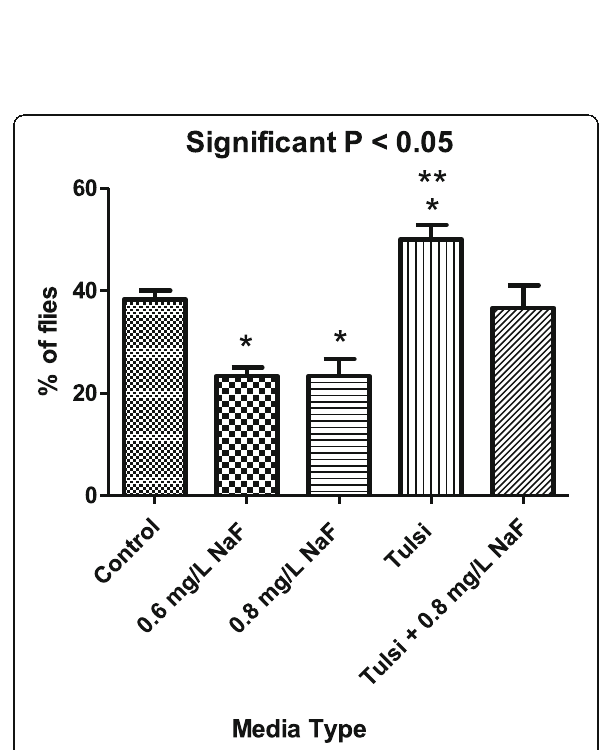
Fig. 3 Climbing ability of Drosophila melanogaster after 06 days of eclosion. *, significant difference between control vs NaF; **, significant difference between tulsi vs NaF